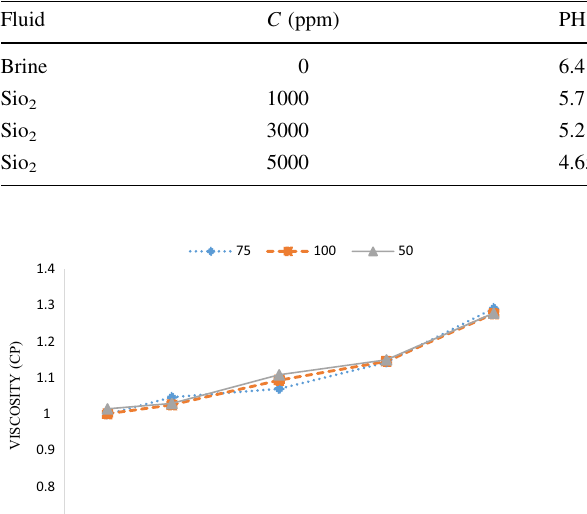
Table 6 pH measurement